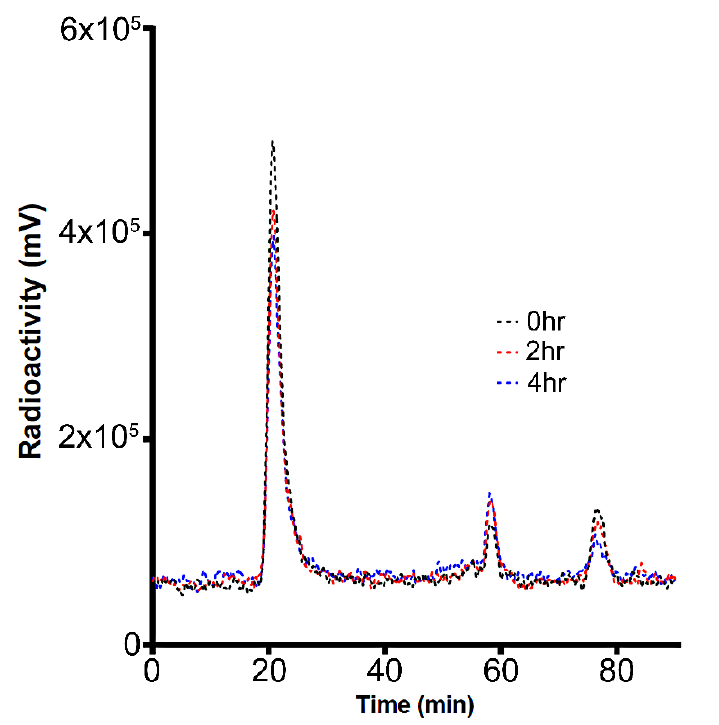
Figure 1. Radiochemical stability test for [ 124 I]I-UC-MSC-EVs. The samples were incubated for 0, 2, and 4 h to assess radiochemical stability. The results indicated that the radiochemical purity of [ 124 I]I- UC-MSC-EVs was >95% (T = 0, 2, and 4 h), and only two minor peaks were